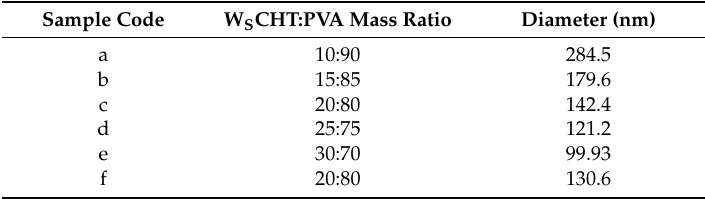
Figure 2. Scanning electron microscopy (SEM) images of W S CHT/PVA nanofibers; ( a ) 10:90; ( b ) 15:85; ( c ) 20:80; ( d ) 25:75; ( e ) 30:70 and ( f ) Crosslinking of CR ( c ) 20:80. Table 2. Diameter of prepared nanofibers.